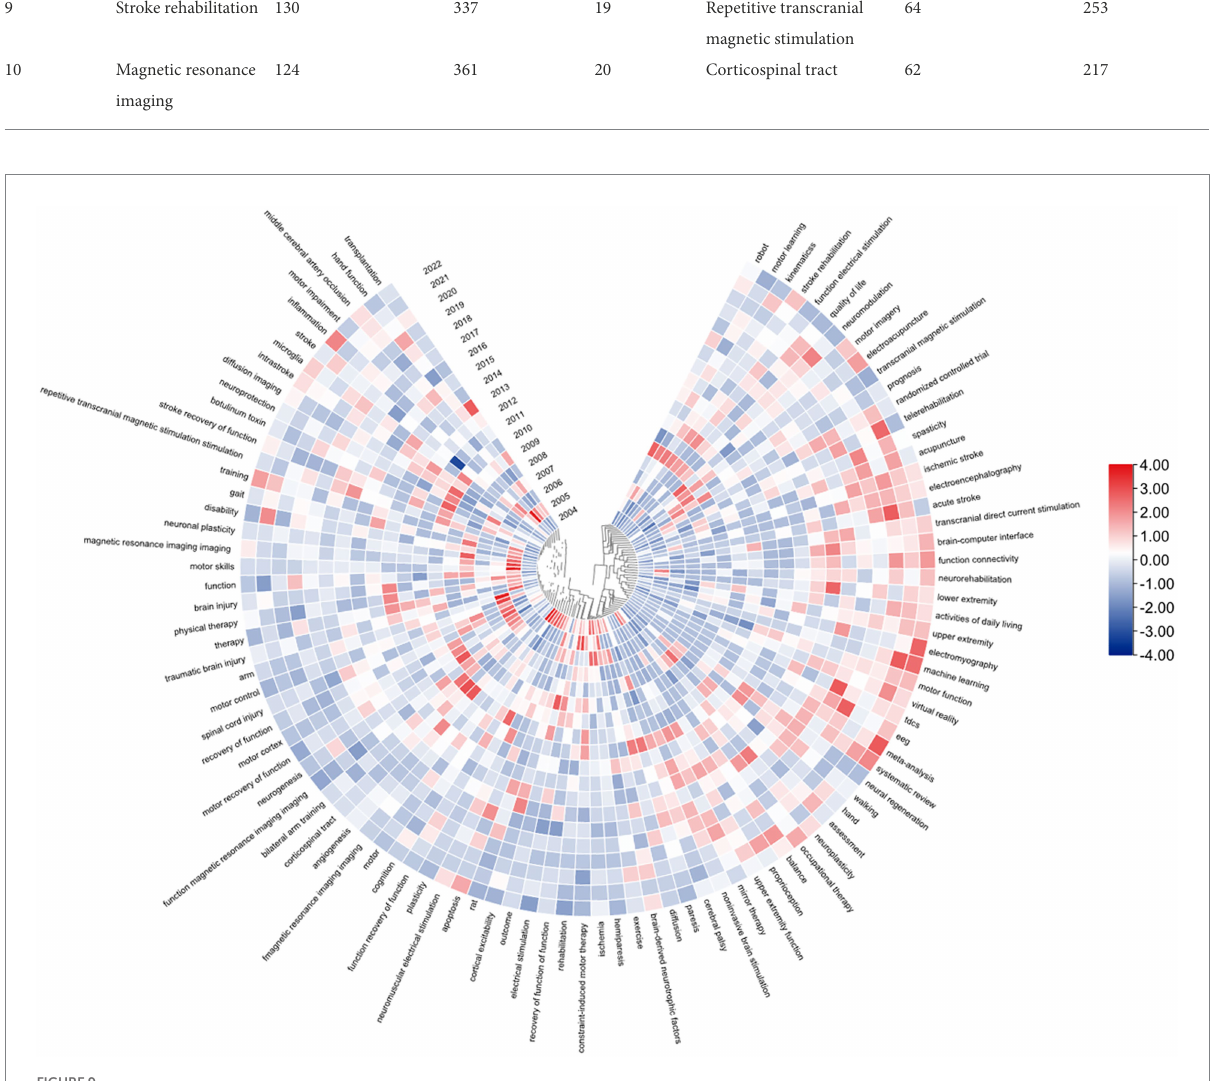
FIGURE 9 Keywords heat map on stroke motor function